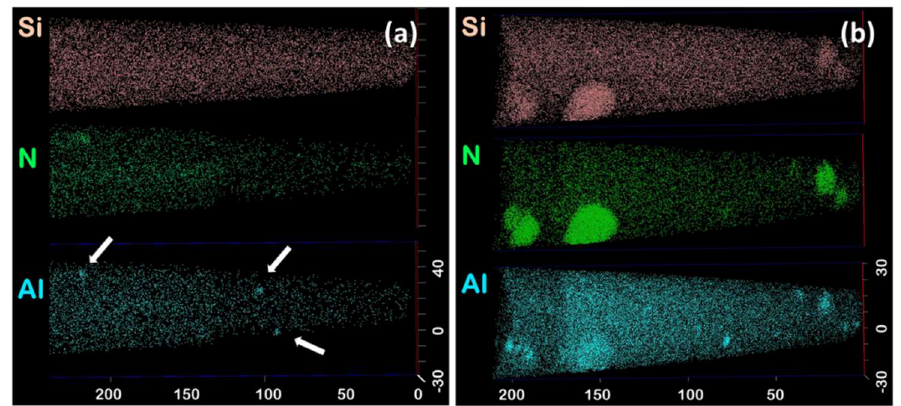
Figure 1. Tomograms of Si, 15 N, and Al in ( a ) the as-nitrided sample and ( b ) after 20 h of annealing. The arrows indicate Al–N clusters. Only 50% of detected Si atoms are shown for clarity (Scale in nm). Table 1. Atomic compositions of the Fe–Si alloy, after cold rolling, nitriding, and annealing. Compositions in the annealed sample are given separately for the ferritic matrix and Si 3 N 4 precipitates. Al–N clusters are also excluded for the calculation of matrix composition. The error is calculated from counting statistics, according to [35].